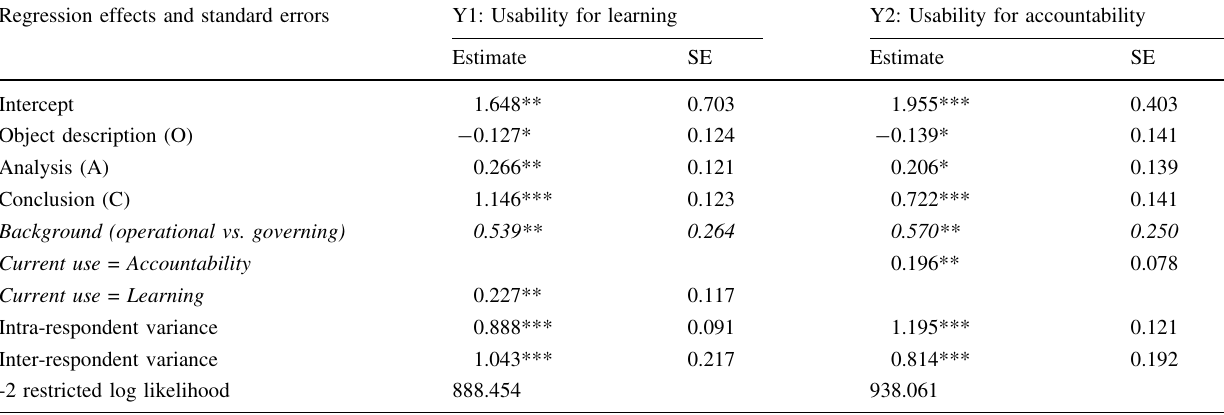
Table 6 Multilevel model summary, main effects Regression effects and standard